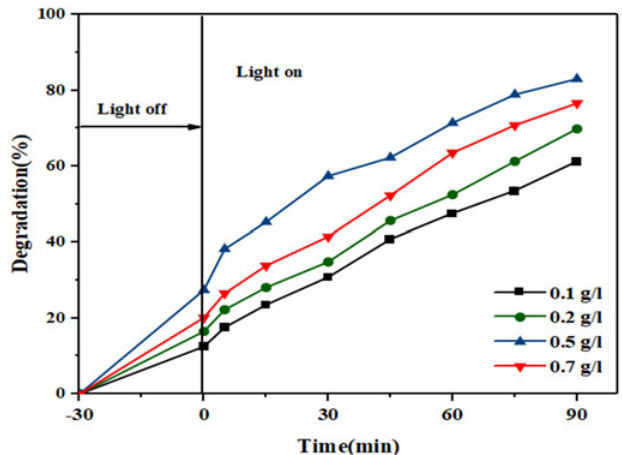
Fig. 5. Effect of nanocomposite concentration on photodegradation of